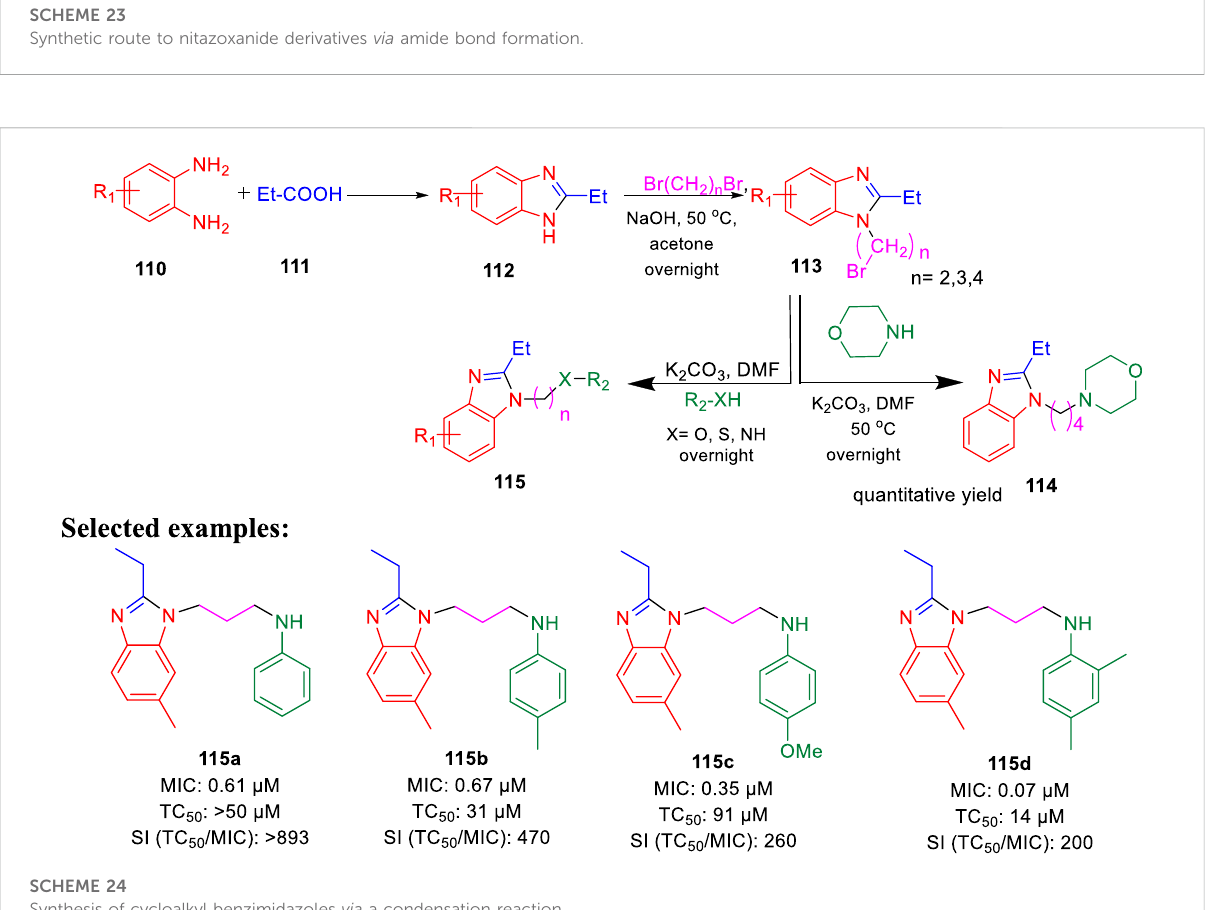
SCHEME 23 Synthetic route to nitazoxanide derivatives via amide bond